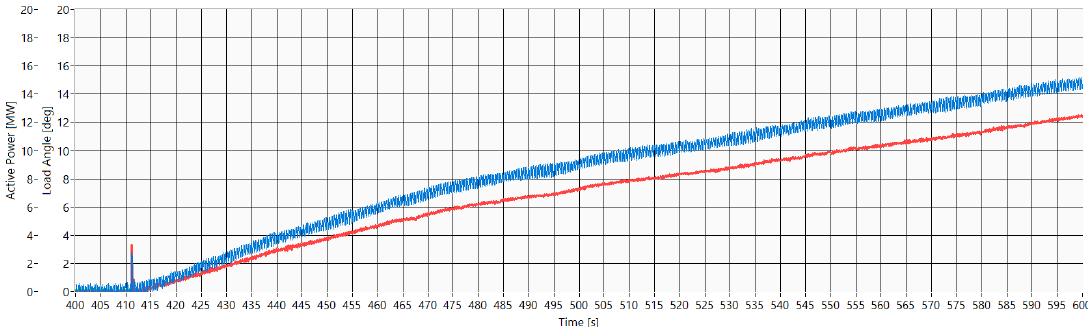
Figure 17. Testing results of the load angle measurement algorithm of the synchronous generator under continuous change of the active power. The red curve represents the active power measurements and the blue curve the load angle measurements.